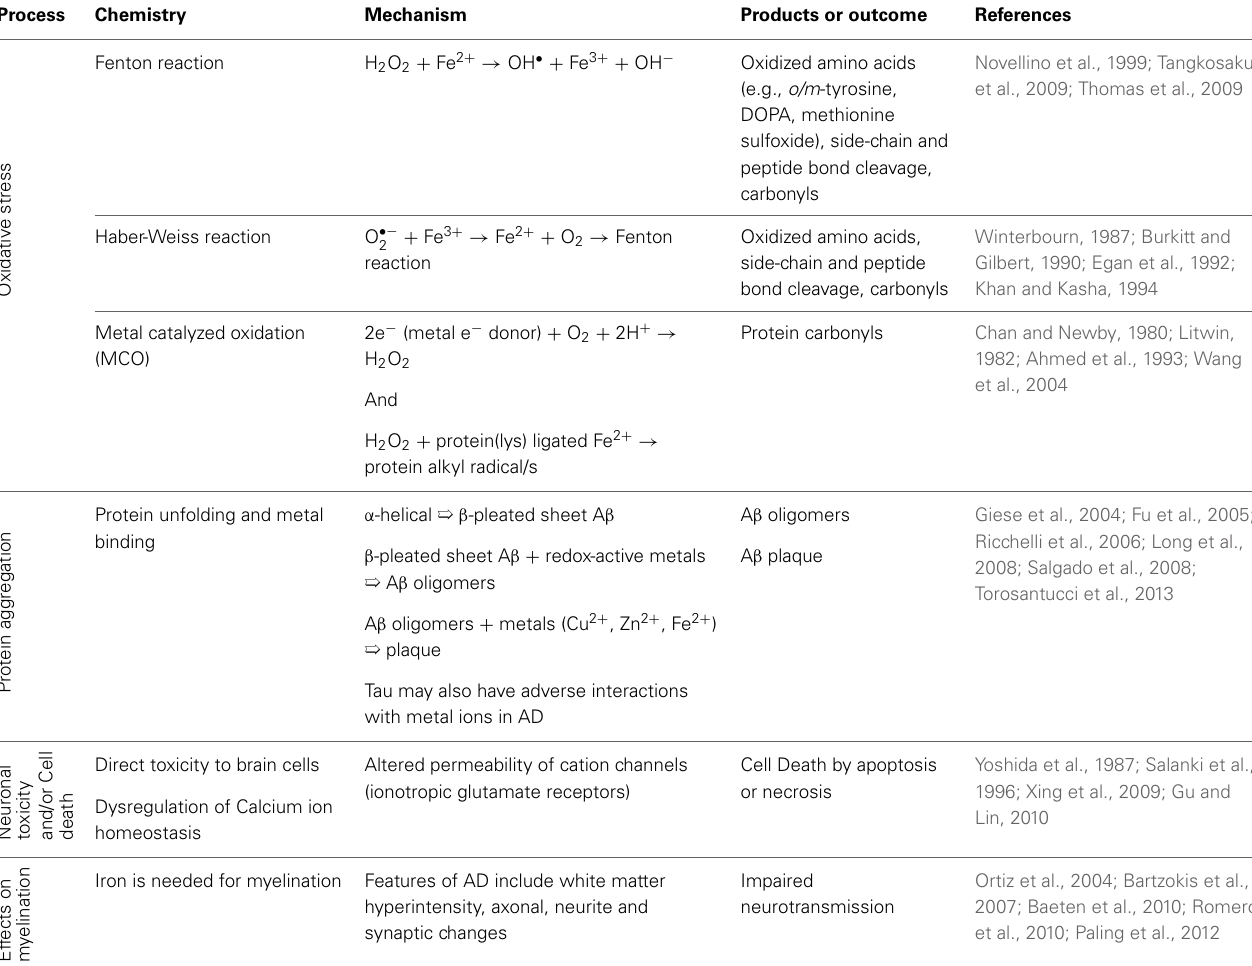
Table 2 | Processes in the Alzheimer’s Disease Brain linked with metals.